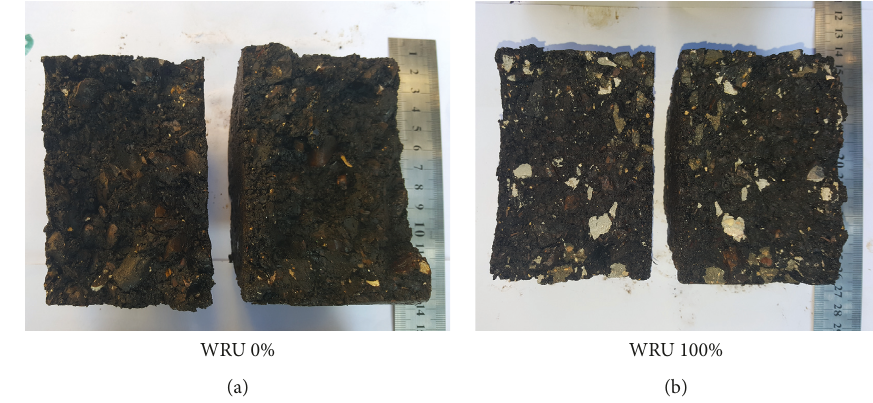
Figure 10: Tensile strength ratio results.